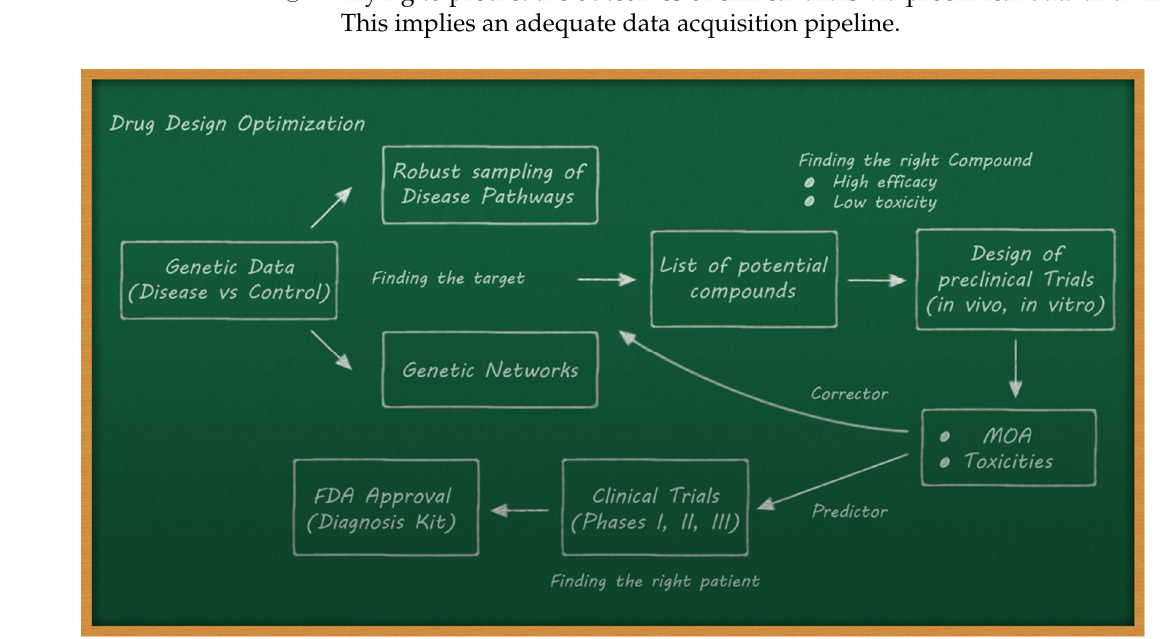
Figure 2. A possible predictor–corrector methodology for drug design.